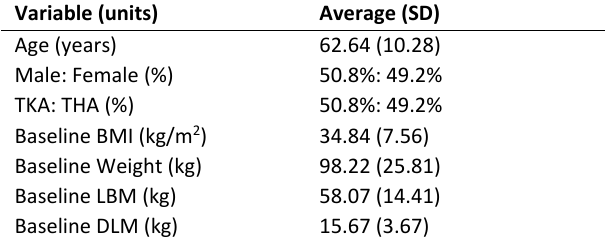
Table I. Demography of patients and select pre-operative markers.